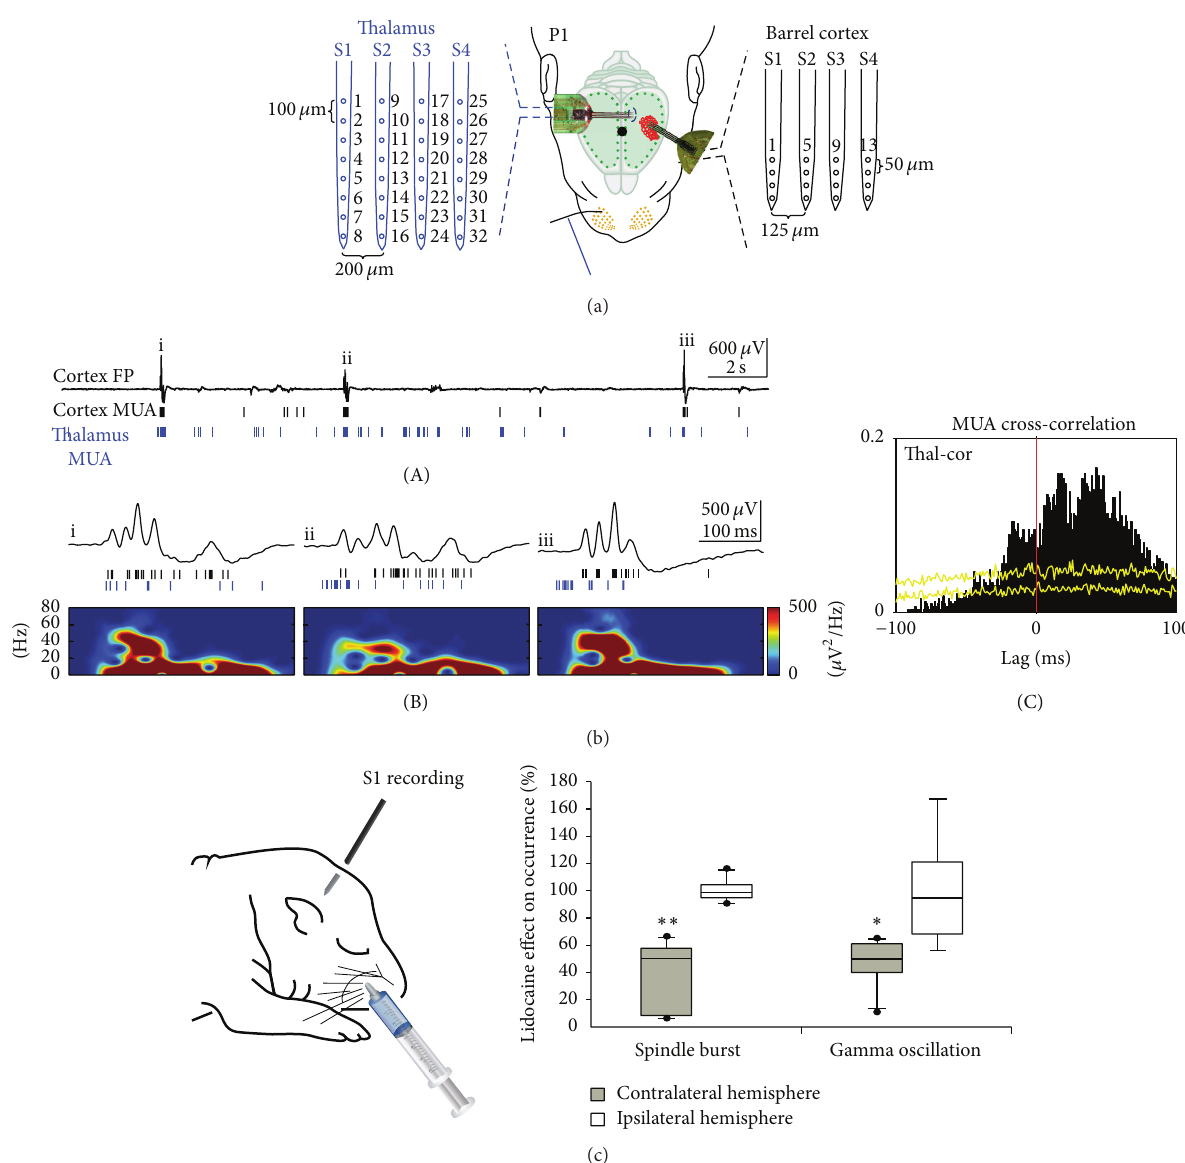
Figure 4: Subcortical origin of spontaneous spindle bursts and gamma oscillations. (a) Schematic illustration of the experimental setup for simultaneous multichannel recordings of sensory evoked and spontaneous activity in both the thalamus and barrel cortex of a newborn rat. A 4-shank 32-channel electrode is located in the ventral posteromedial nucleus (VPM) of the thalamus (blue) and a 4-shank 16-channel electrode in the cortex (black). (b) Simultaneous 40 s recording of spontaneously occurring activity in the barrel cortex and VPM thalamus of a P1 rat. Upper trace represents the cortical FP recording; cortical (black bars) and thalamic MUA (blue bars) are presented below (A). The 3 spontaneous events i–iii marked in (A) are shown at higher resolution with corresponding spectrograms (B). Cross-correlogram of the spontaneous multiunit activity recorded simultaneously in the thalamus and barrel cortex (C). Yellow lines represent results from the shuffled dataset (for details see [18]). (c) Inactivation of the sensory periphery by injection of 2% lidocaine into the whisker pad (left) causes a significant reduction in the relative occurrence of spindle bursts and gamma oscillations recorded in the contralateral barrel cortex of 6 newborn rats (filled bars), whereas both activity patterns in the ipsilateral cortex are not affected (open bars). Data are expressed as box plots, and asterisks mark significant differences ∗ 𝑃 < 0.05 and ∗∗ 𝑃 < 0.01 . Reproduced with permission from [18] (a, b) and from [17]